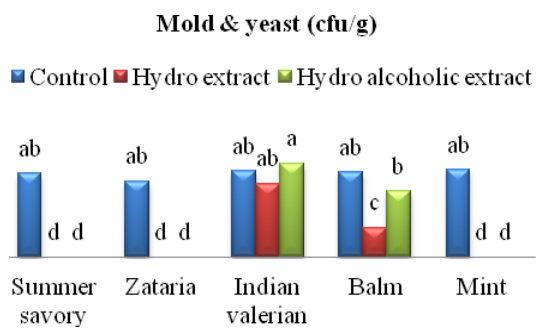
Tab. 6. Variance analysis of microbial load in brewing medicinal